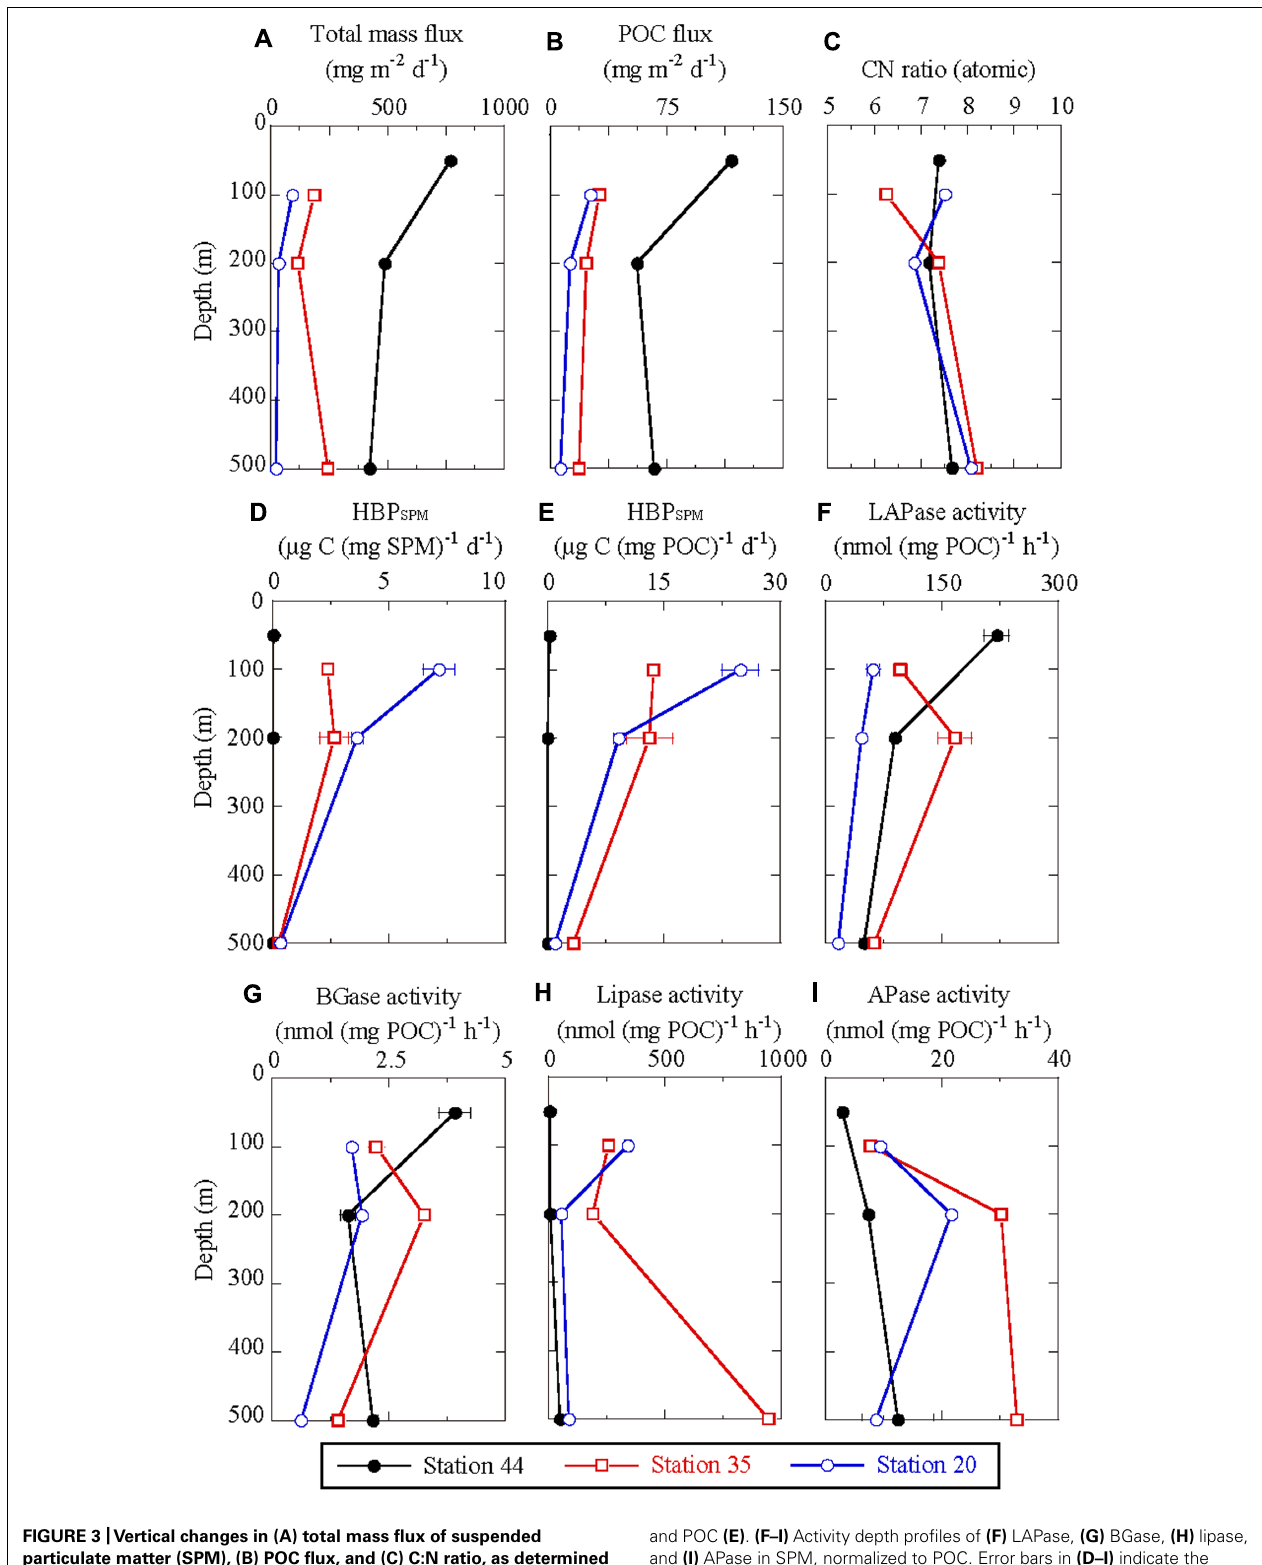
FIGURE 3 |Vertical changes in (A) total mass flux of suspended particulate matter (SPM), (B) POC flux, and (C) C:N ratio, as determined from sediment trap experiments. (D,E) Depth profiles of HBP SPM determined using 3 H-TdR incorporation, normalized to SPM dry-weight (D)